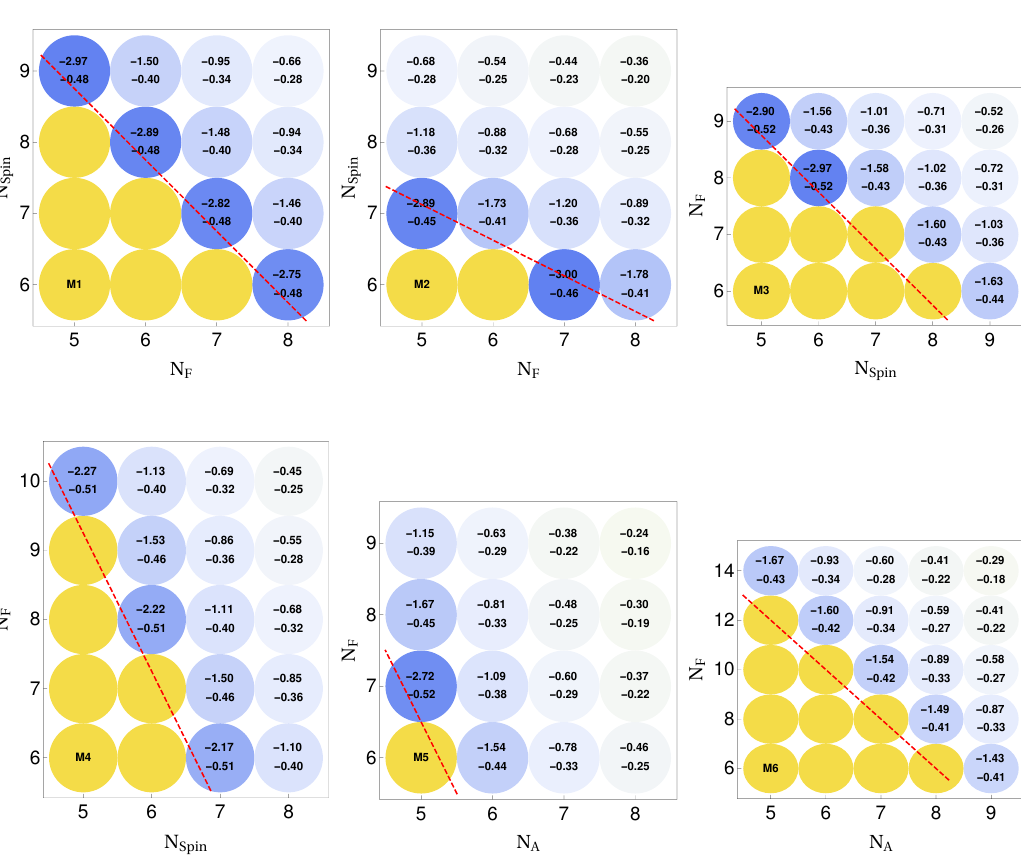
Figure 3: Models M1 to M6 and their neighbours with N representing the number of X Weyl fermions in the X representation. Yellow circles represent potentially confining models whereas blue circles represent models likely to be in the conformal window, with the estimated maximal and minimal value of γ ∗ displayed. Our heuristic argu- ments for this classification are described in the text. The red dashed curve indicates the “conformal house” [ 21 ]